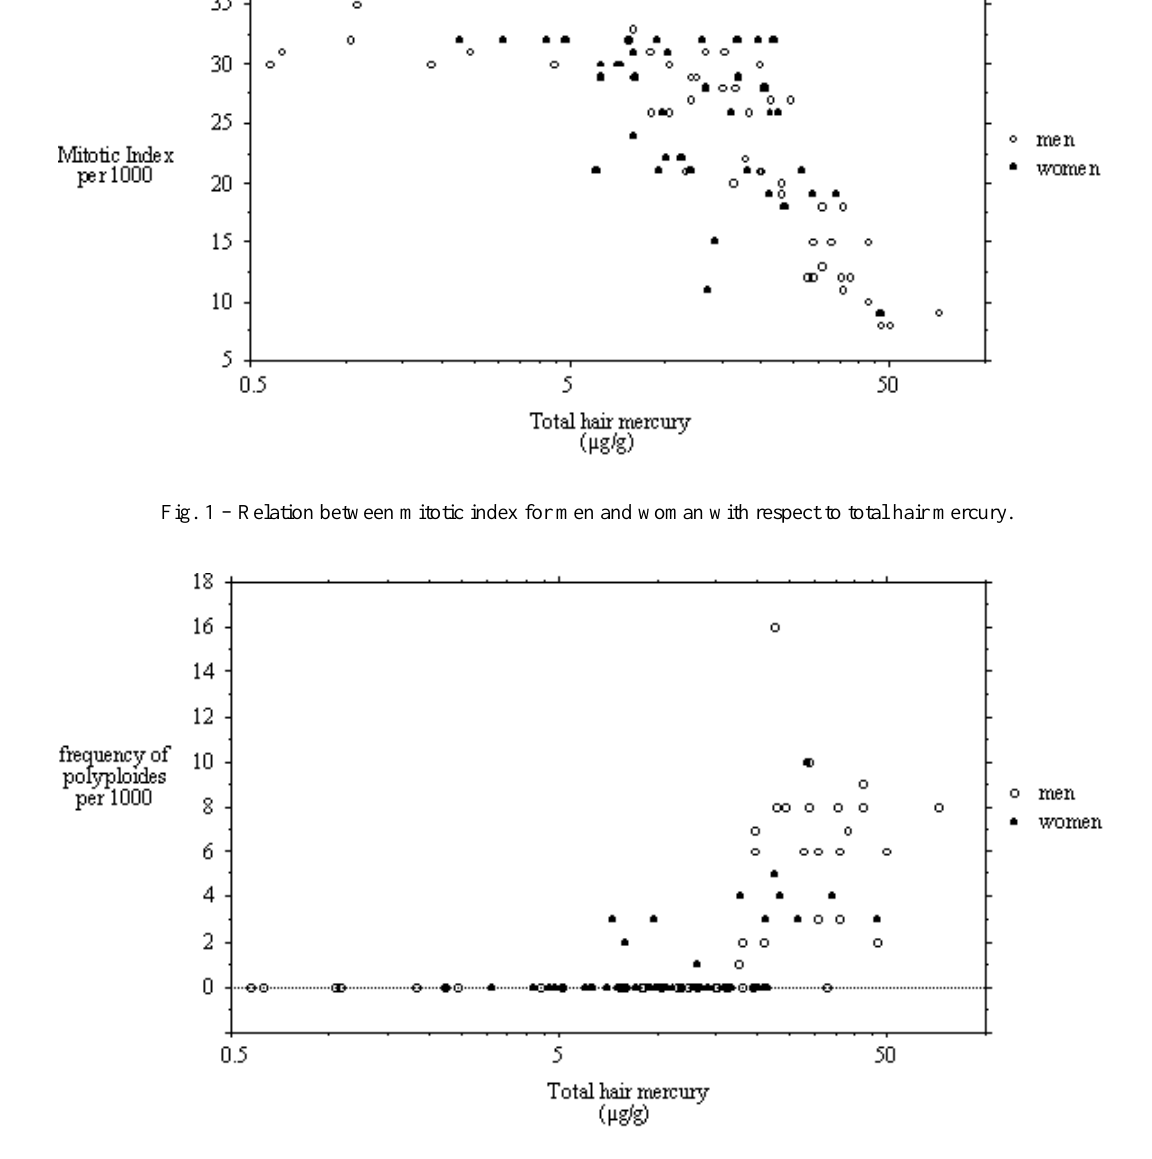
Fig. 2 – Relation for men and woman for polyploidal aberrations frequency and hair mercury